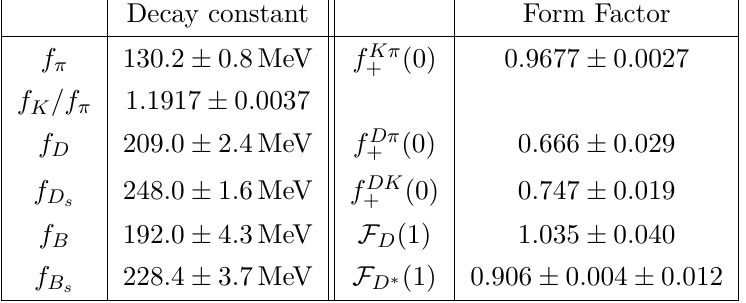
Table 5 . Pseudoscalar meson decay constants and form factors as determined from lattice QCD calculations. Here we use the FLAG lattice averages with n